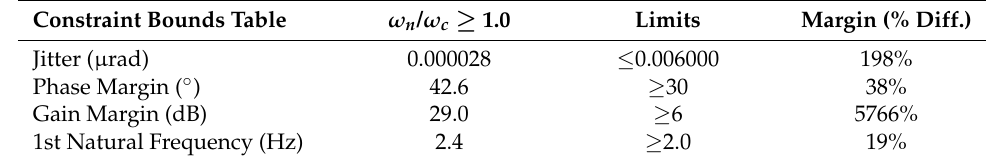
Table 2. Numerical result of constrained, feasible, not “bound” system design.